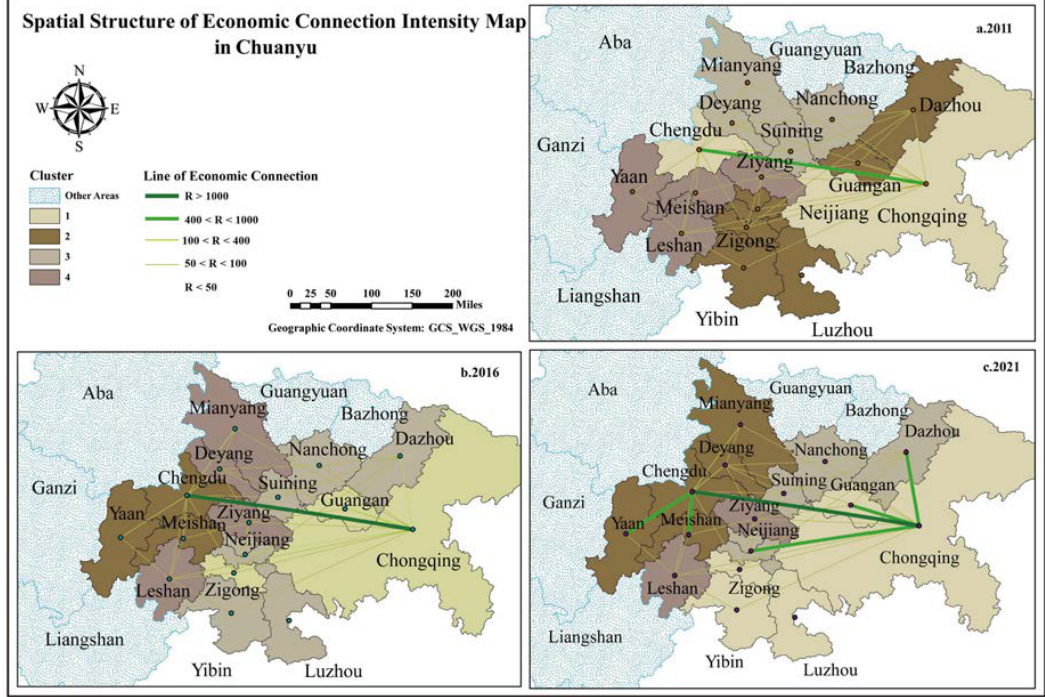
Figure 3. Spatial structure of economic connection intensity map in Sichuan-Chongqing (Chuanyu).